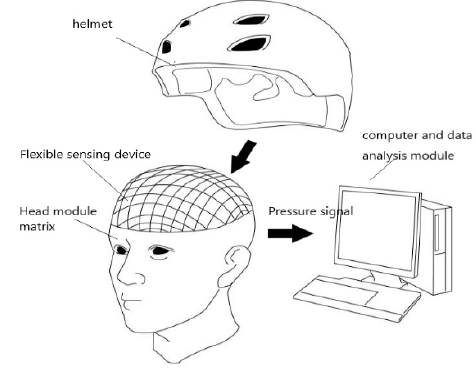
Figure 1. Overall functional design of the system.